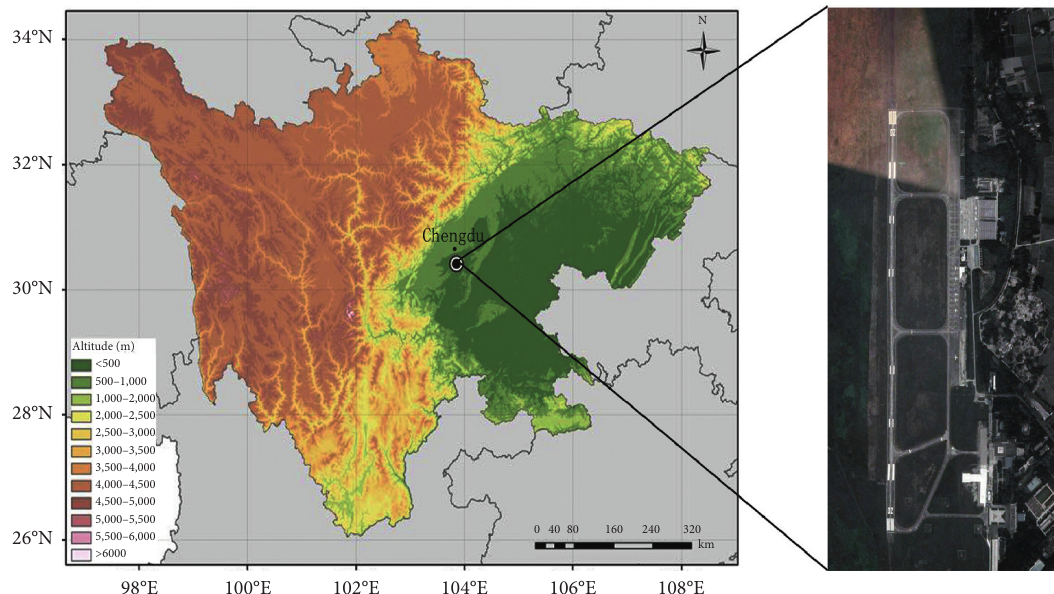
Figure 1: The geographical location of Sichuan Province and Xinjin